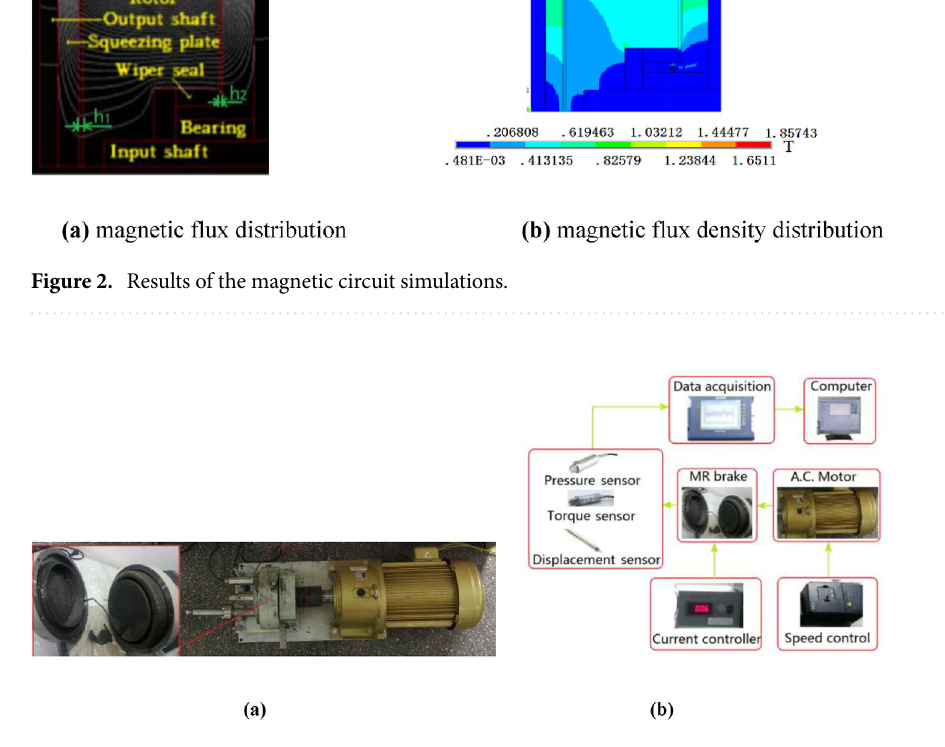
Figure 3. ( a ) An experiment prototype; ( b ) block diagram experiment layout of proposed MR